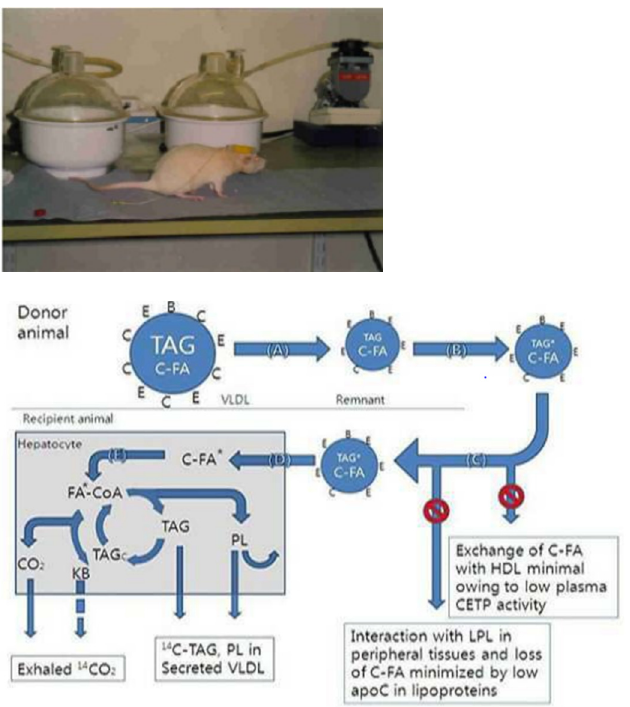
Figure 2. In vivo monitoring technique to metabolic distribution of glycerolipid in obesity animal biomodels. * Indicate the metabolic pathway of cholesteryl-[ 14 C]-oleate which is breakdown from TAG* (TAG newly synthesed by cholesteryl-[ 14 C]-oleate) in the hepatocyte. A–E indicated Apolipoproteins.